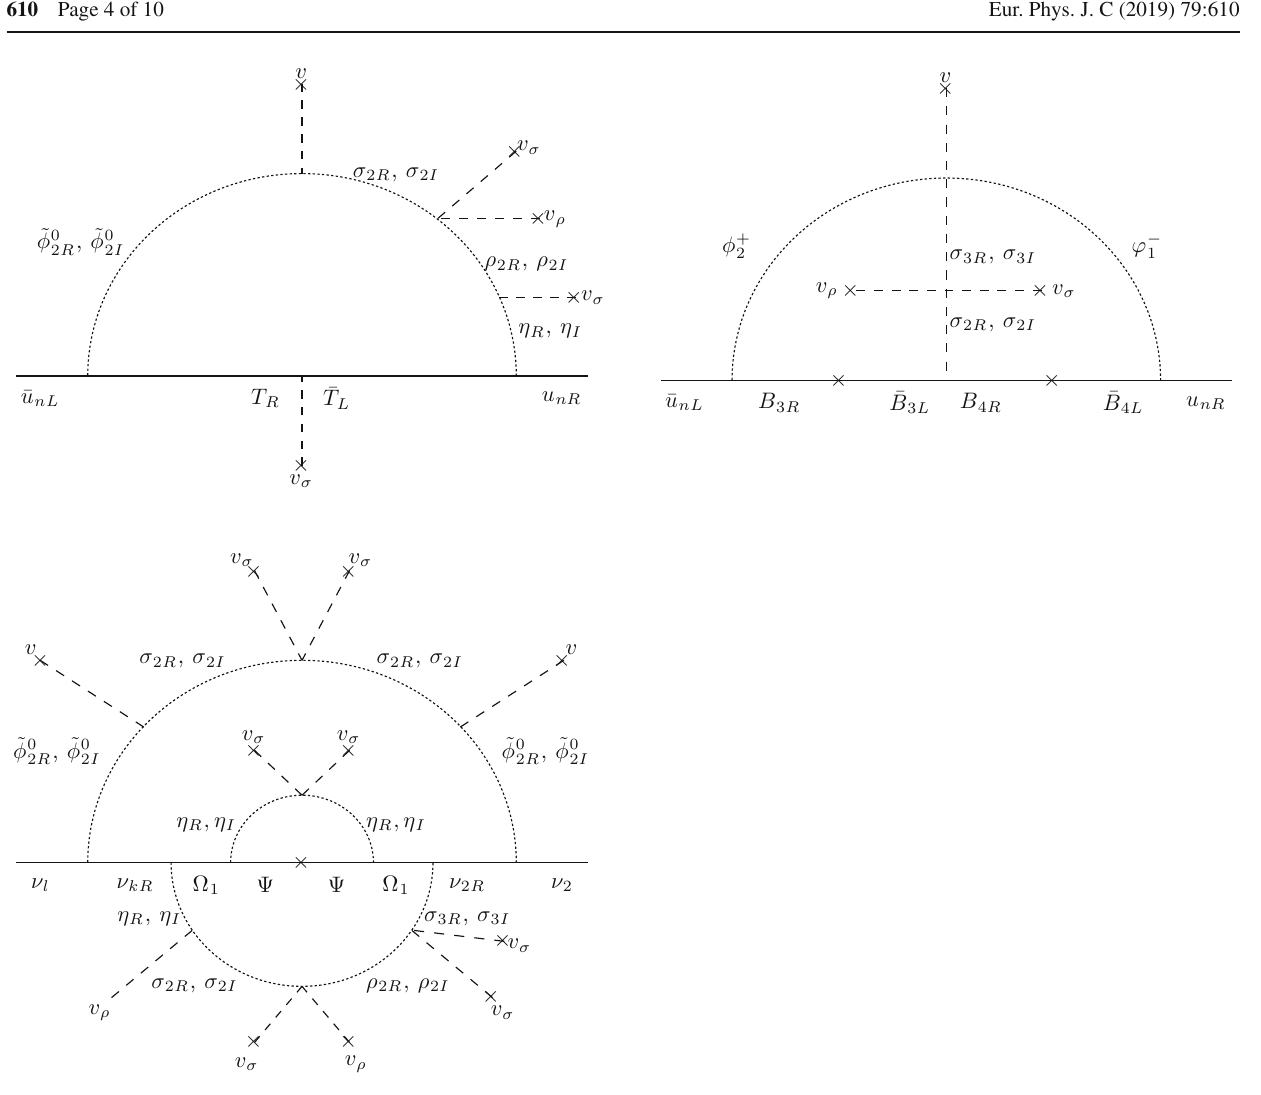
Fig. 1 Some of the one-, two- and three-loop Feynman diagrams contributing to the entries of the SM fermion mass matrices. Here, n , m = 1 , 2, l , n = 1 , 3 active neutrinos get their masses from a three-loop level radiative seesaw mechanism. Some of the one-, two- and three-loop Feynman diagrams contributing to the entries of the SM fermion mass matrices are shown in Fig. 1. More details are given in our previous